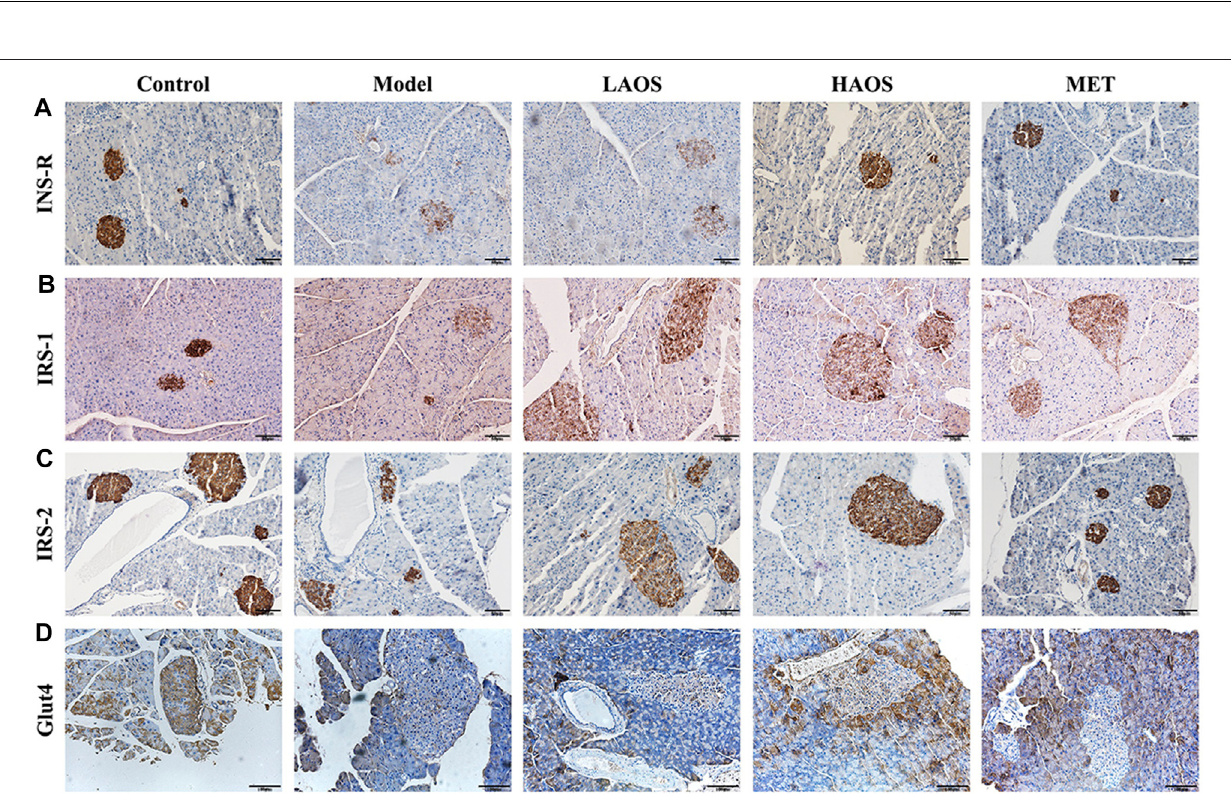
Frontiers in Pharmacology |